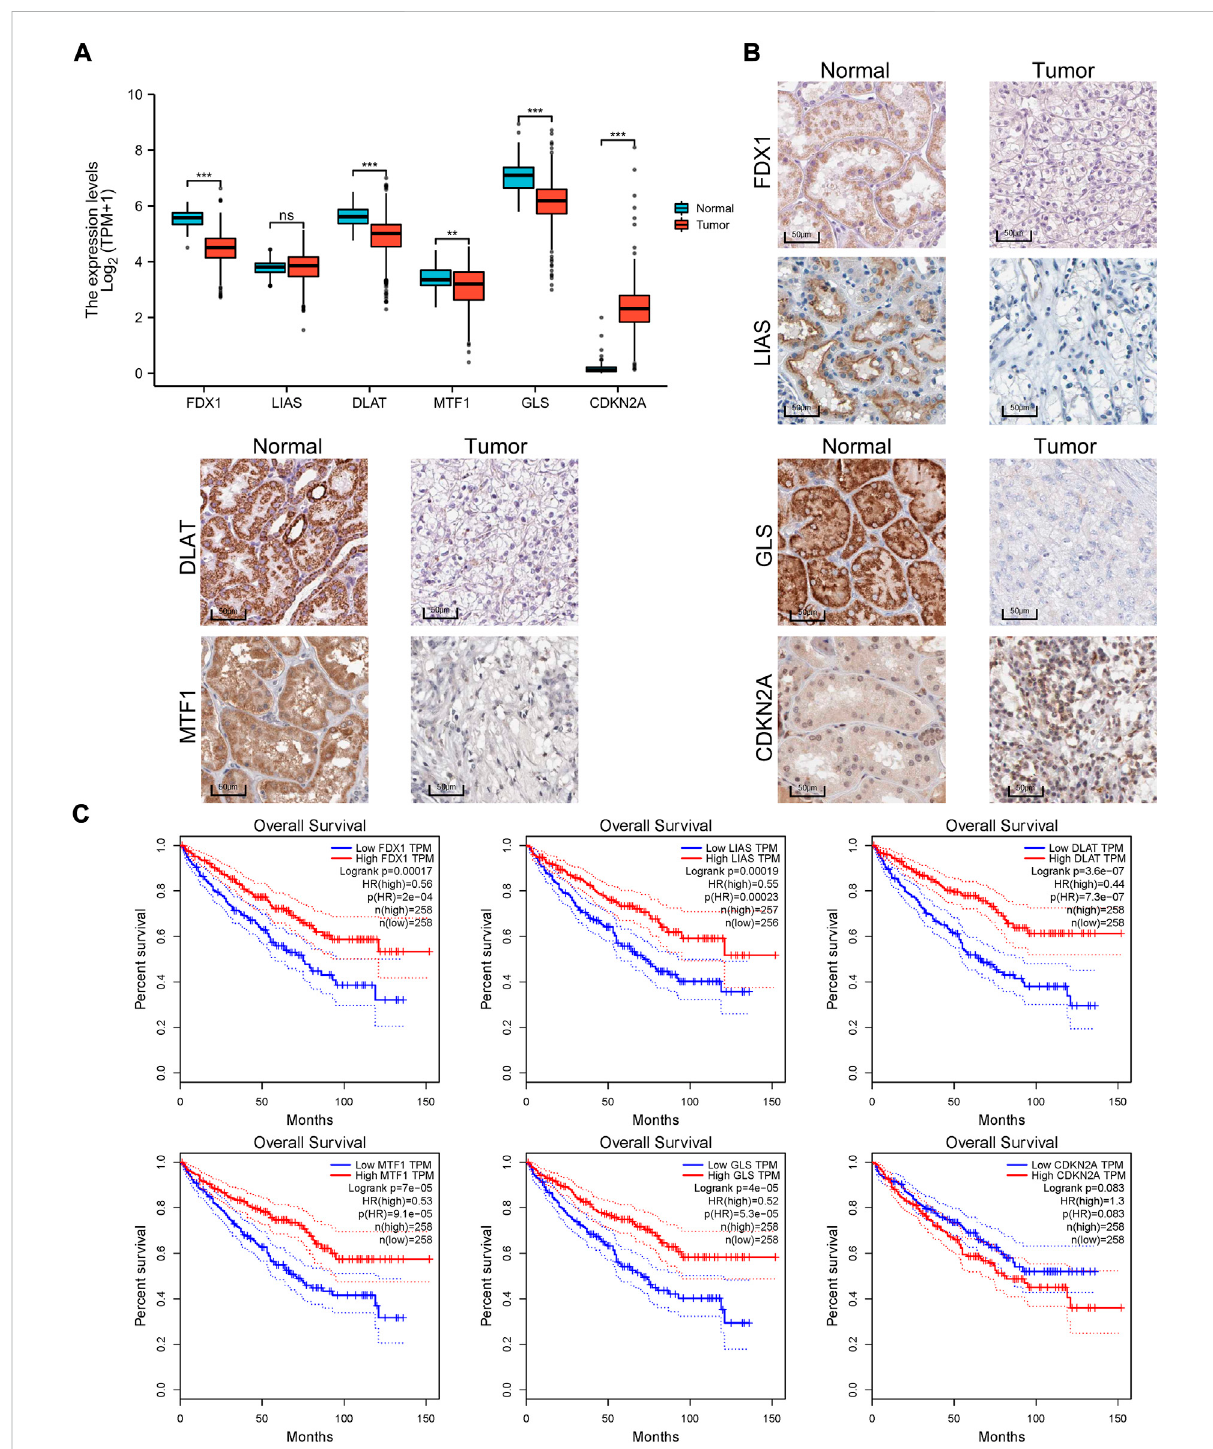
FIGURE 5 Expression differences and survival of the signature genes. (A) Box plot of the expression difference of signature genes between normal and ccRCC tissue according to TCGA sequencing data. (B) IHC of FDX1, LIAS, DLAT, MTF1, GLS, and CDKN2A between tumor and normal tissue according to the Human Protein Atlas cohort. (C) Survival curves of six genes involved in the prognostic signature. IHC, immunohistochemistry.